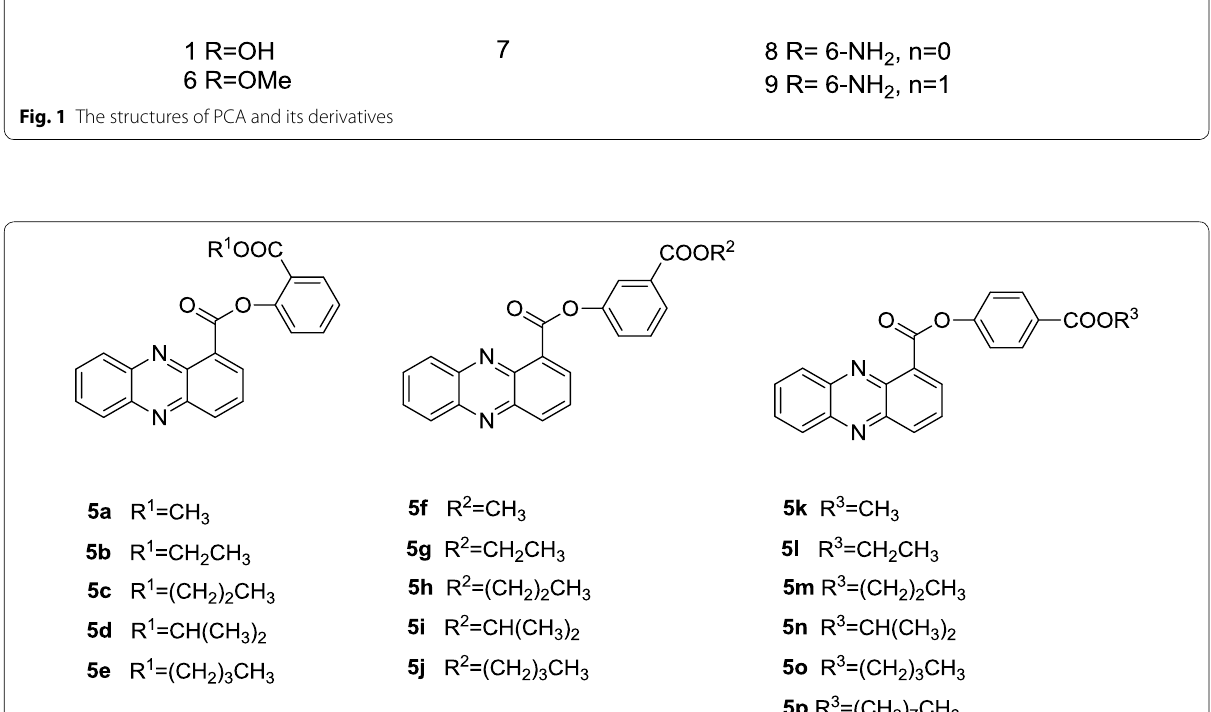
Fig. 2 The structures of PCA–salicylic acid ester conjugates ( 5a – 5e ), PCA-3-hydroxybenzoic acid ester conjugates ( 5f – 5j ) and PCA- p -hydroxybenzoic acid ester conjugates ( 5k – 5p